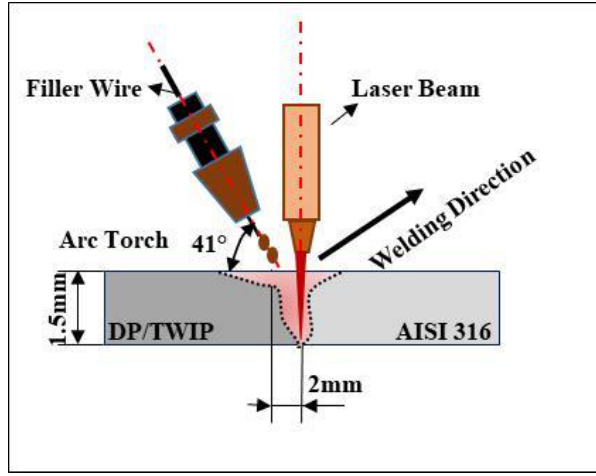
Figure 1. Layout of the hybrid laser-arc welding process. Table 1. Chemical composition of twinning-induced plasticity (TWIP) and dual phase (DP) steels (wt %) [20].